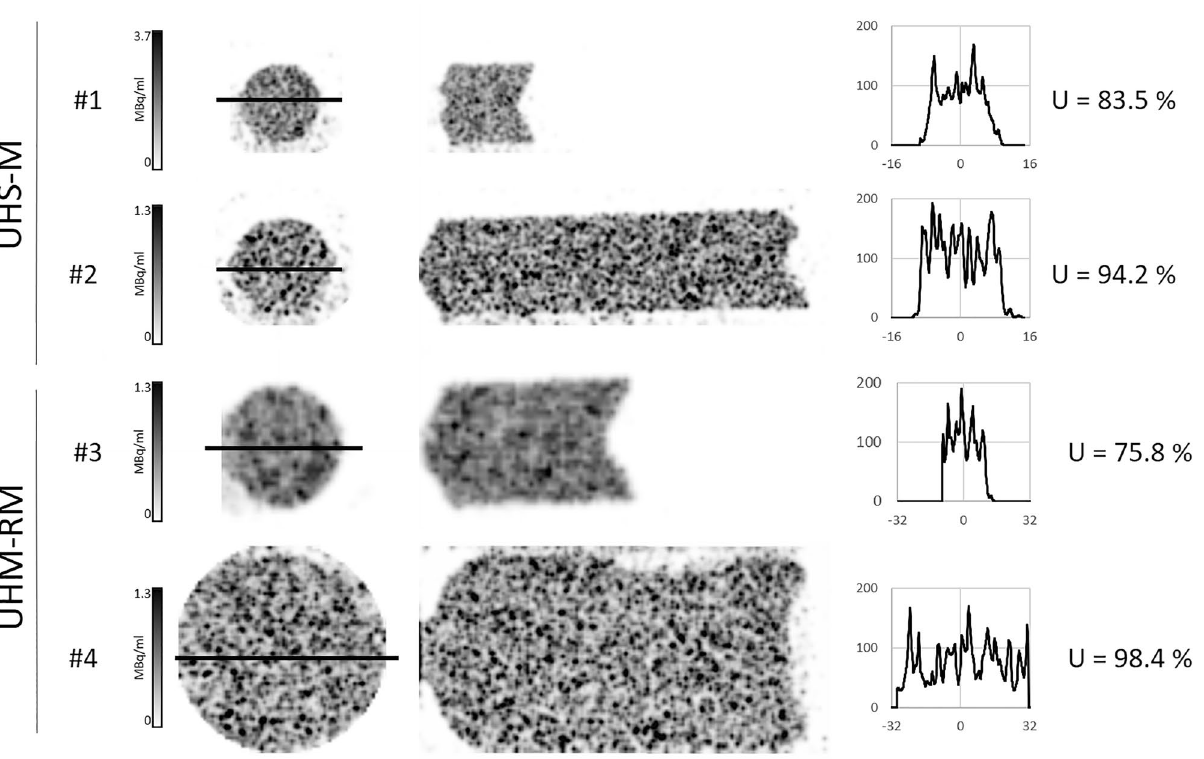
Figure 1. Spatial resolution values obtained with the Derenzo phantoms for the UHS-M (up) and UHR-RM (down) collimators. The image on the left shows the CT acquisition of the phantom, whereas SPECT images follow on the right. The first two images represent the same activity concentrations but different reconstruction (minimum voxel size and standard reconstruction). The color bar was adjusted according to the radioactive concentration within the phantom. Stars are used in the figure to mark the minimum distinguishable rod in each